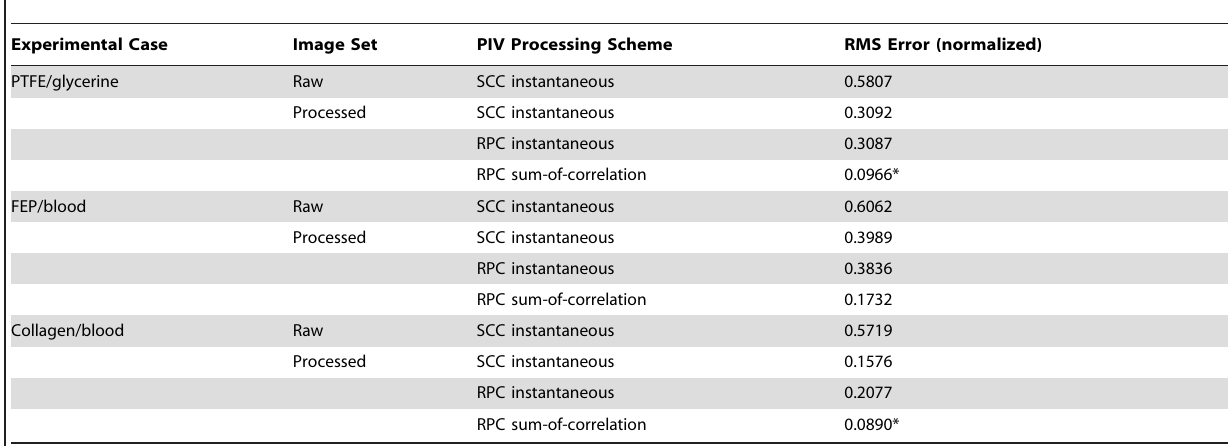
Table 1. RMS deviation of experimental mean velocity profile from volume-adjusted theoretical solution, normalized by volume- adjusted theoretical maximum